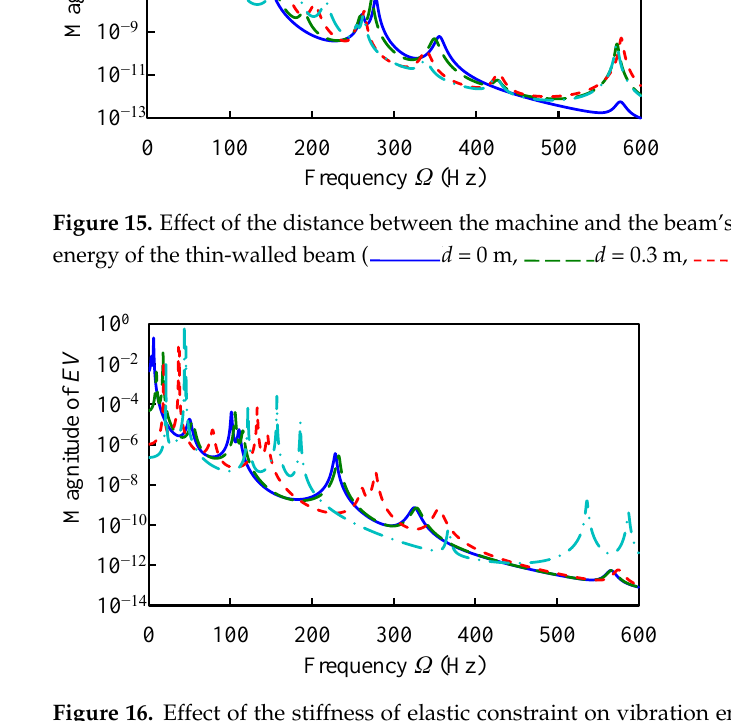
Figure 15. Effect of the distance between the machine and the beam’s axis of symmetry on vibration energy of the thin-walled beam ( d = 0 m, d = 0.3 m, d = 0.6 m, d = 0.9 m).